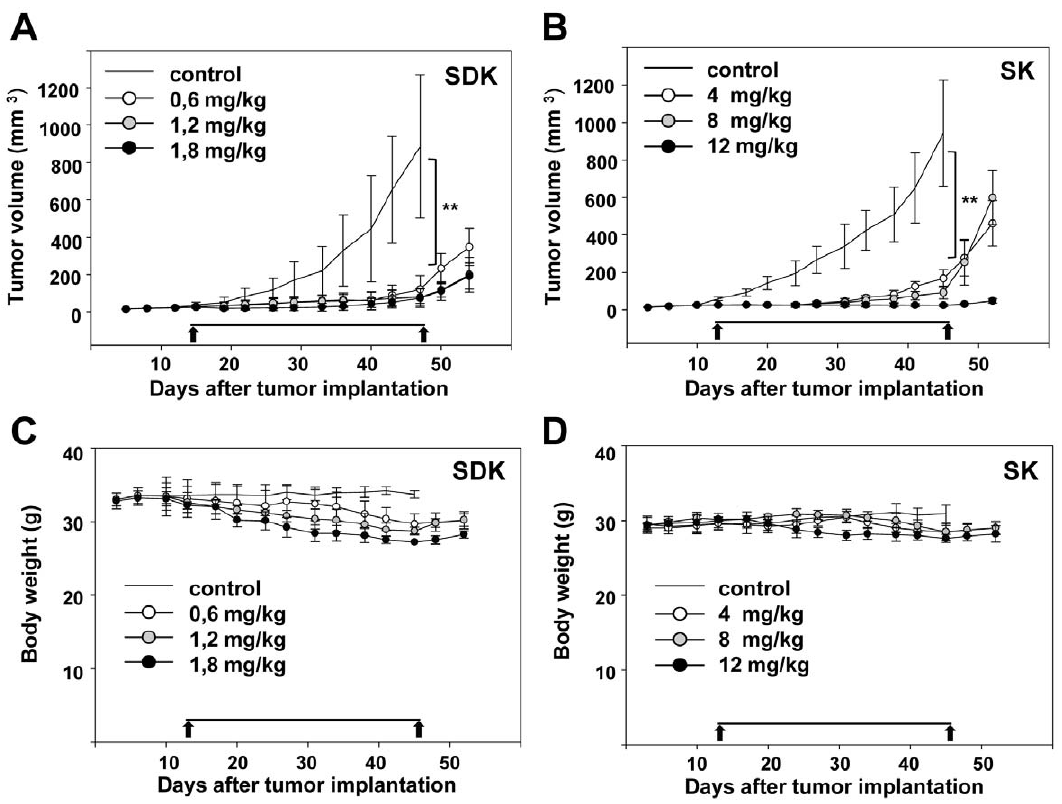
Figure 5. Antitumor activity of MTM-SDK and MTM-SK in subcutaneous prostate tumor xenografts. Mice with subcutaneous tumors were treated with the indicated doses of MTM-SDK, MTM-SK or sterile saline solution (control) given by IP injections twice a week for five weeks (q3d 6 10). Tumor volume (A) and body weight (B) were measured twice a week. Results are expressed as mean 6 SD of the tumor volume in each group. Arrows indicate start and end of the treatment. **, P , 0.001.